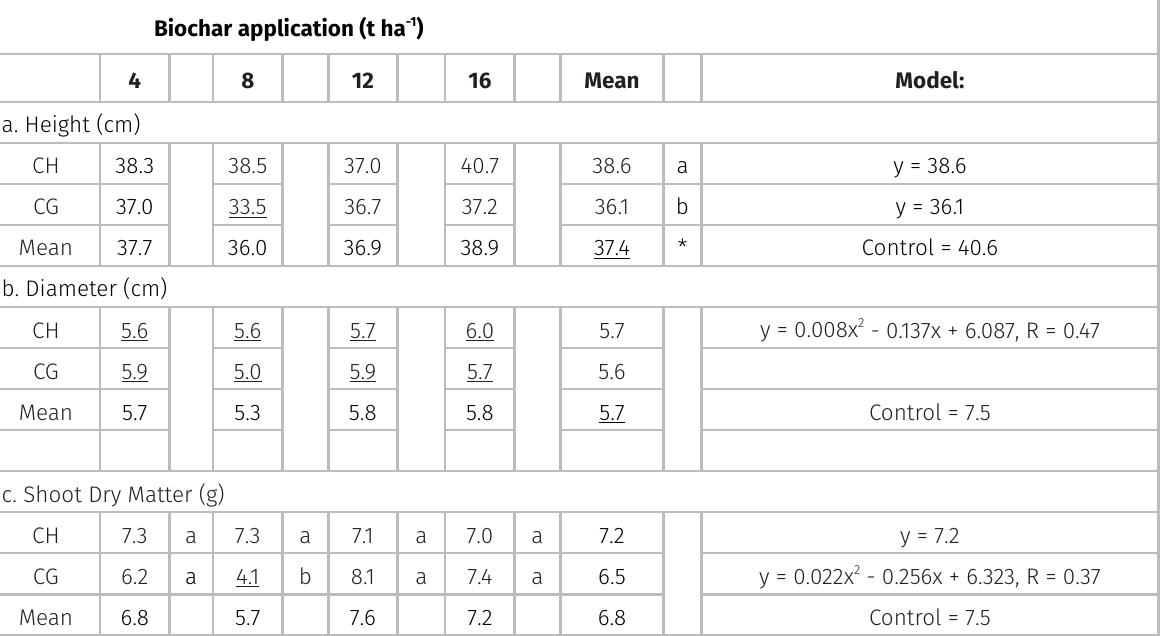
Means with different letters between lines differ statistically from each other by the Tukey test (ρ <0.05). The absence of letters indicated statistically similar by the F test (ρ <0.05) and the underlined averages differed significantly by Dunnett test (ρ <0.05). Only the significant regressions by the F test (ρ <0.05) were calculated, and the others returned a mean (constant) representative of the dosages evaluated. * Comparison of the general means with that of the additional treatment (control) according to the F test (ρ